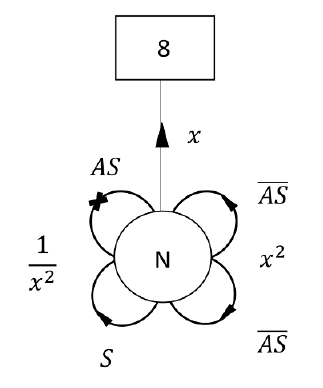
Figure 3 . The 4 d theories associated with the torus compacti(cid:12)cation of the SU(2) (cid:2) E 7 SCFT for N = 2 n and of the SO(16) SCFT when N = 2 n + 1 with (cid:13)ux z = 1 are in the antifundamental of the SU( N ) gauge symmetry. The lines from the group to itself stands for symmetric, denoted by S , antisymmetric, denoted by AS , or their conjugate representation, denoted by a bar. The square with 8 represents an SO(8) or USp(8) global symmetry, depending on the exact choice of